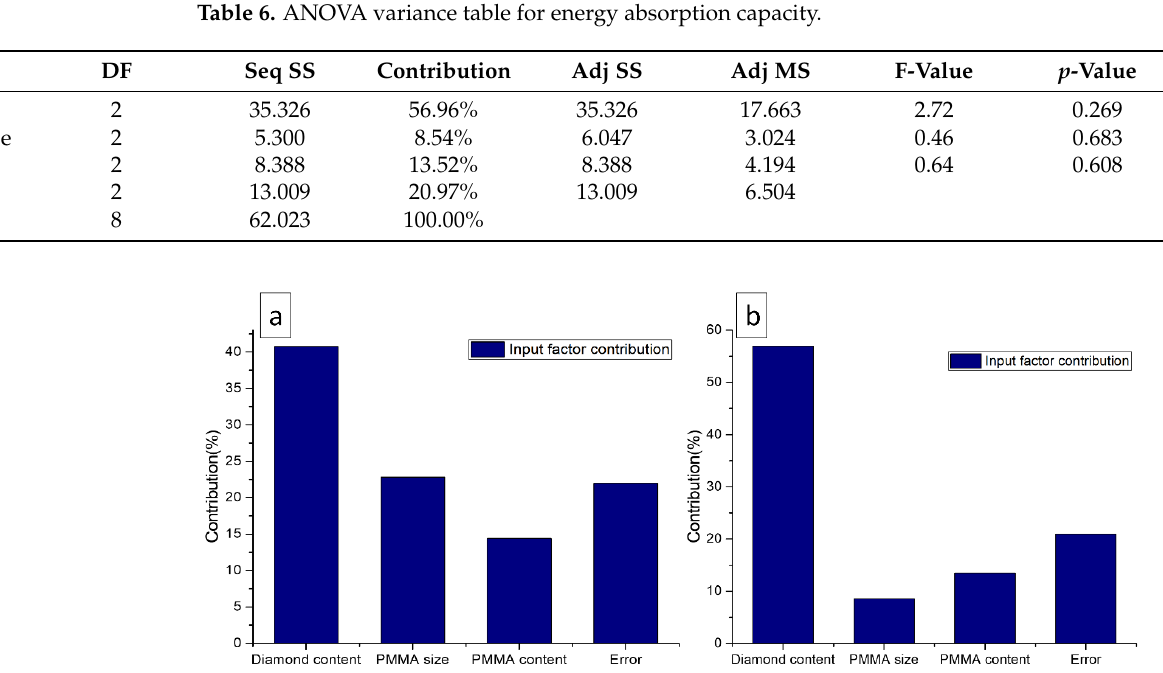
Figure 8. Percentage of the contribution of input factors on, ( a ) plateau stress, and ( b ) energy absorption capacity.